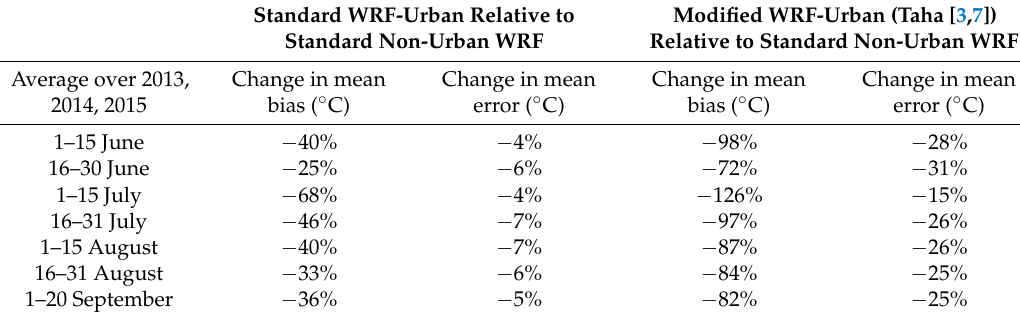
Table 3. Comparison of model performance using standard and customized WRF-urban